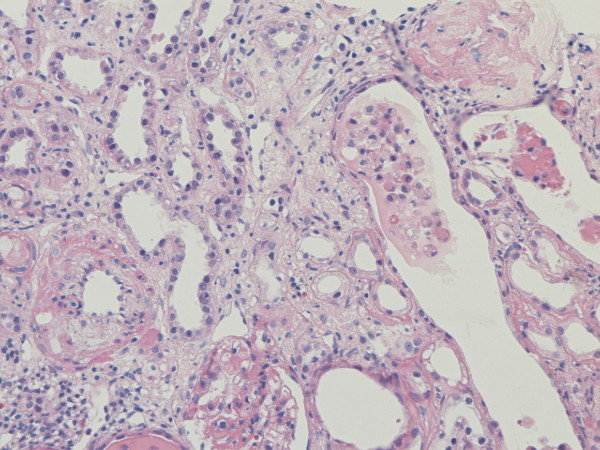
Expression of C4d and renal histology. Interstitial fibrosis/tubular atrophy (HE staining,original magnification × 200).